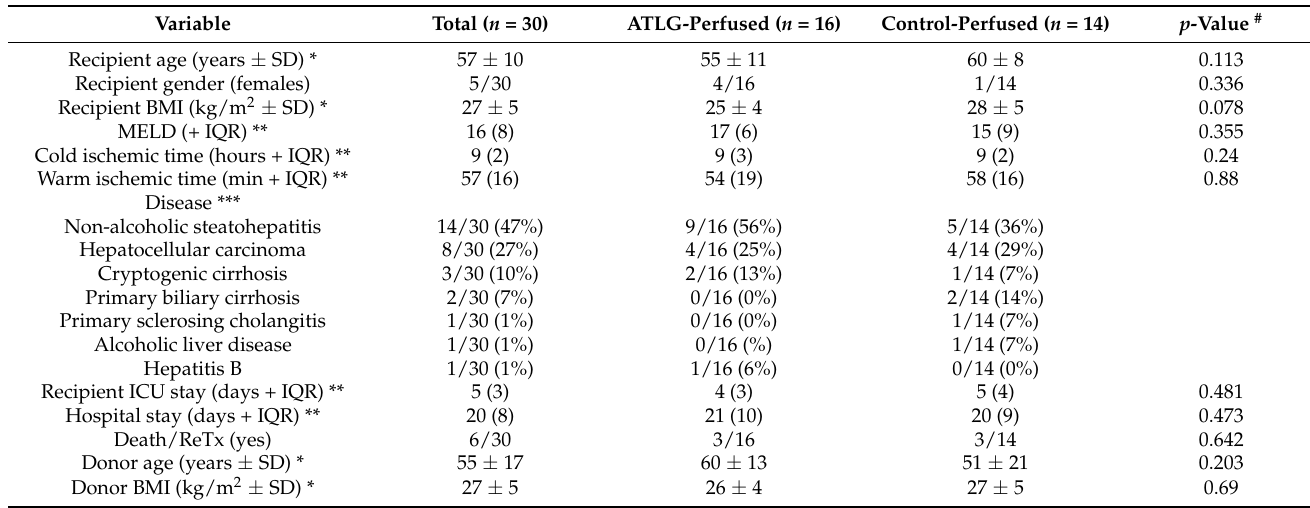
Table 1. Donor and recipient characteristics.